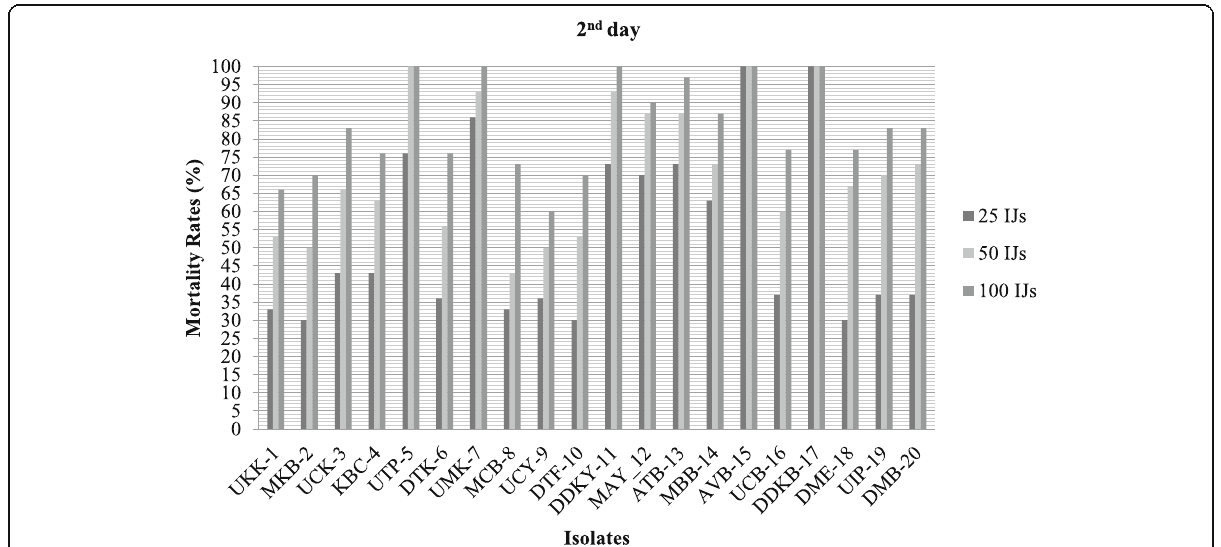
Fig. 2 The mortality rate (%) of entomopathogenic nematode isolates on Galleria mellonella larvae on the second day after treatment at 25 °C (25, 50, and 100 IJs). UKK-1, MKB-2, UCK-3, KBC-4, UTP-5, DTK-6, MCB-8, UCY-9, DTF-10, DDKY-11, MAY-12, ATB-13, UCB-16, DDKB-17, DME-18, UIP-19, and DMB-20: Steinernema feltiae isolate, UMK-7 and AVB-15: Heterorhabditis bacteriophora isolate, MBB-14: Steinernema sp